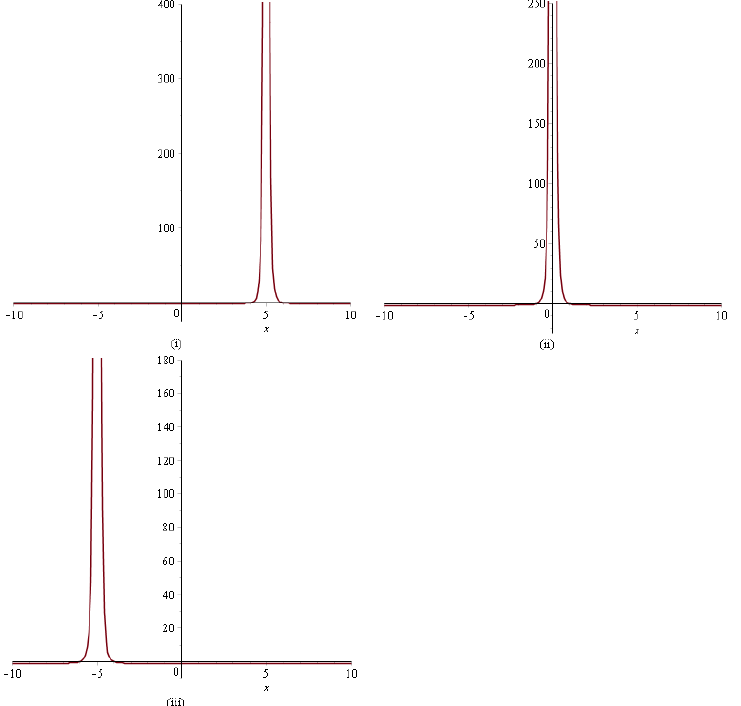
Figure 2. The 2D profiles of solution u r ( x + ν t ) of Equation (1) corresponding to ( i ) x 0 = 5, t 0 = 0,